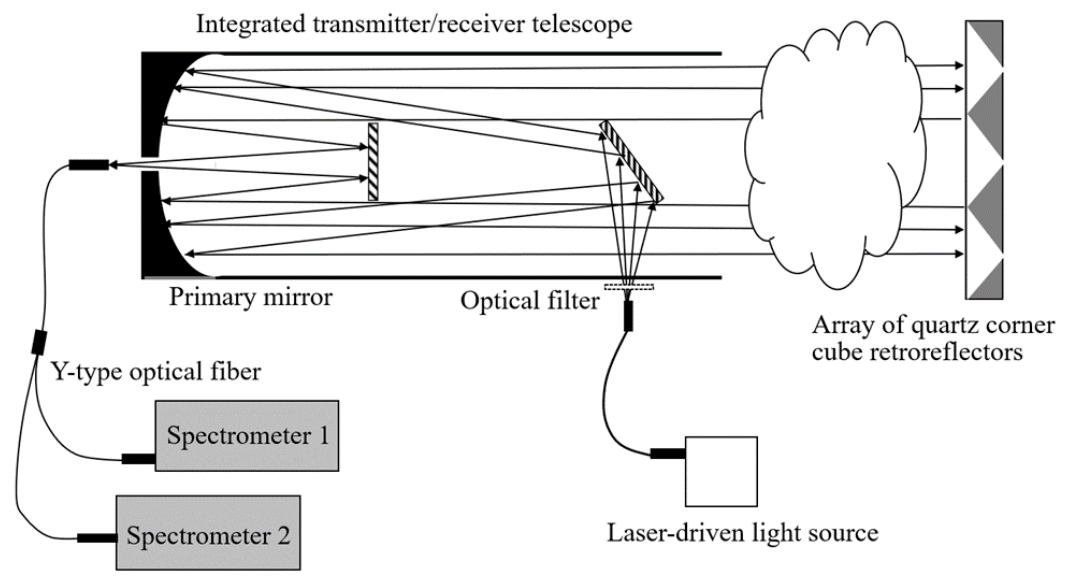
Figure 1. Schematic of the LP-DOAS